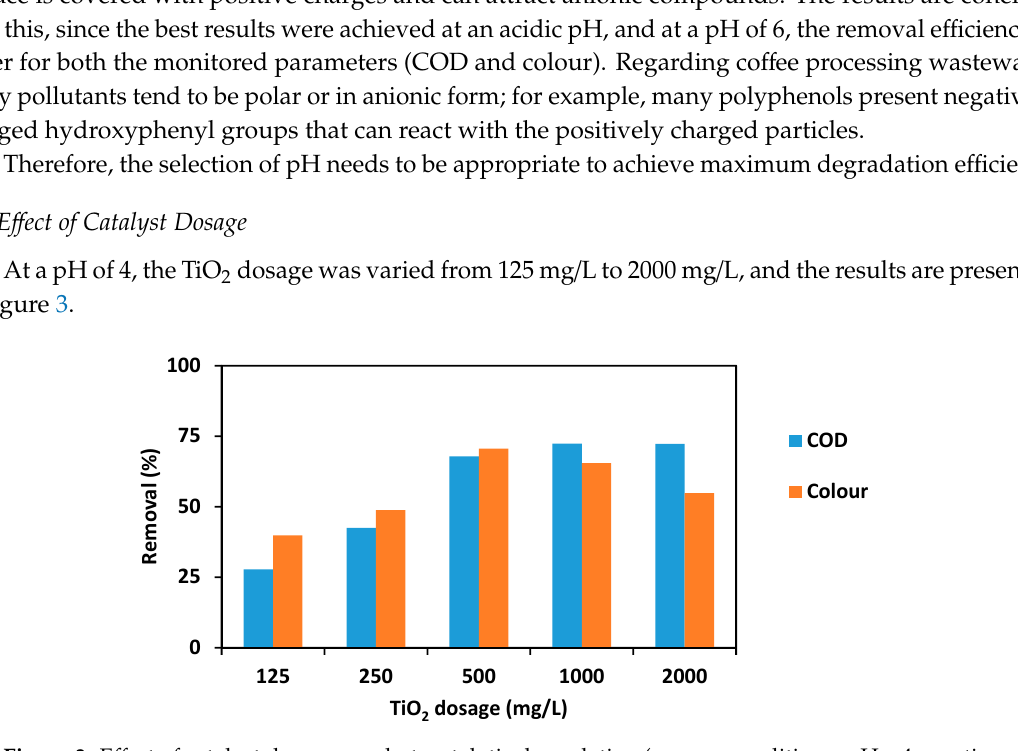
Figure 3. Effect of catalyst dosage on photocatalytic degradation (process conditions: pH—4, reaction time—3 h, UV light irradiation—64 W).